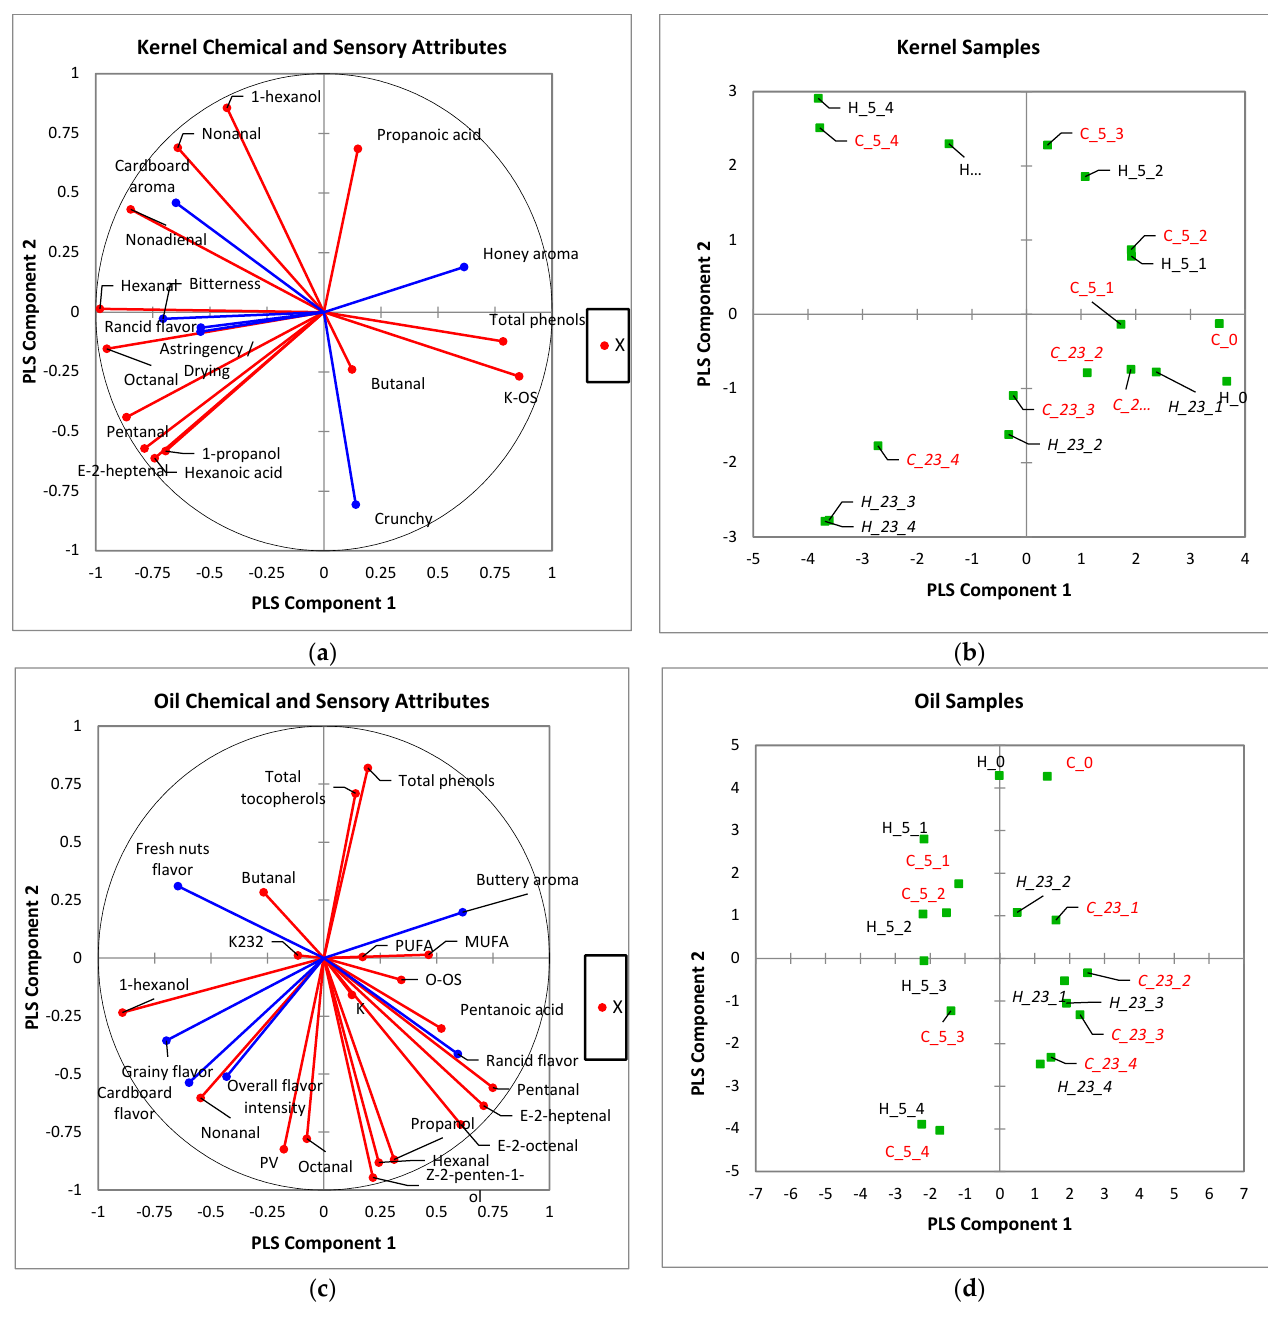
Figure 5. ( a – d ) Graphic explanation of the relationship between chemical oxidative markers and development of rancidity in walnut kernel ( a , b ) and oil ( c , d ) during storage by partial least squares regression analysis.